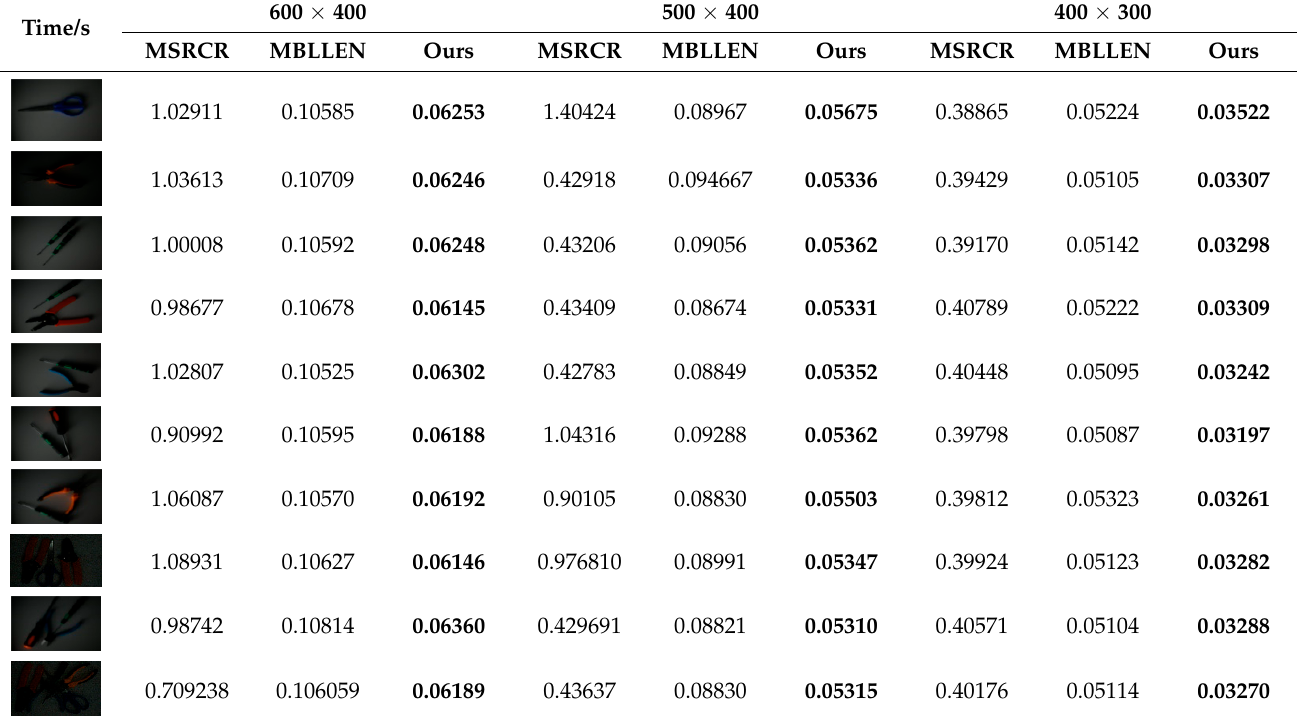
Table 7. Comparison of the processing times of MSRCR, MBLLEN, and DC-WGAN algorithms for different picture sizes. 600 × 400 500 × 400 400 × Time/s